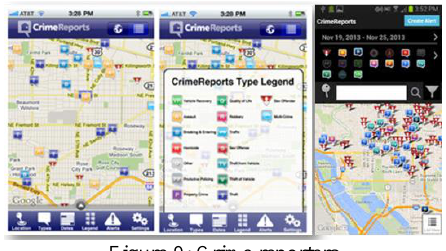
Figure 9: Crime reporters